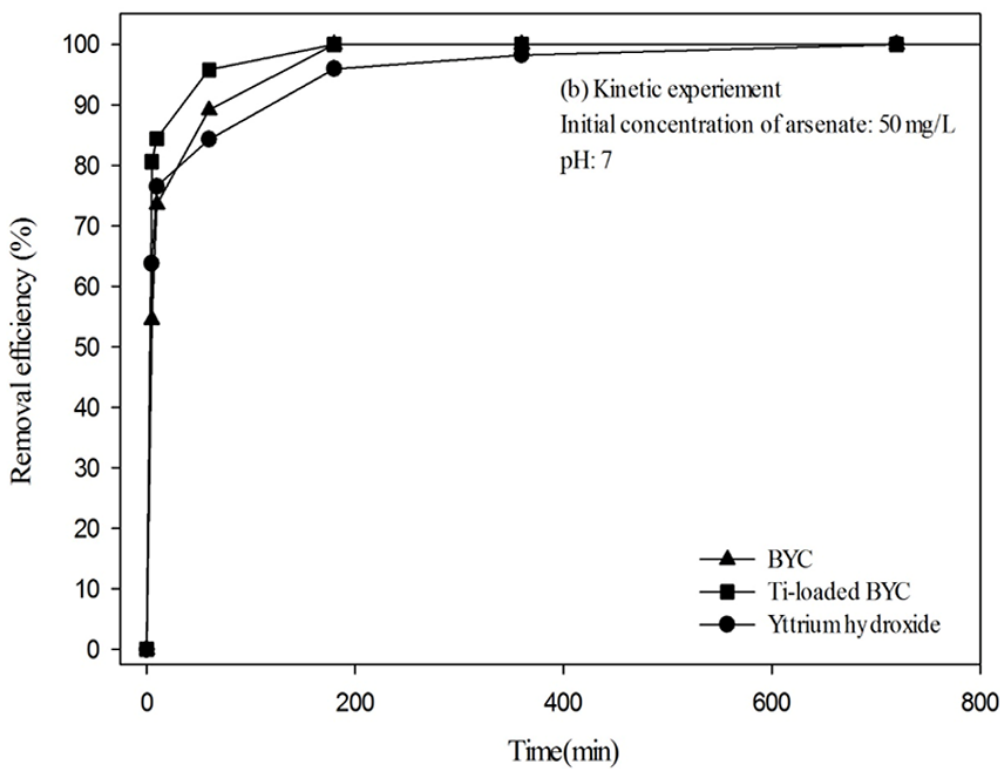
Figure 6. Adsorption efficiency by different pH ( a ) and kinetic results ( b ) of the arsenate adsorption (Initial concentration of arsenate: 50 mg/L; dose: 1 g/L, Reaction time: 24h; Temperature: